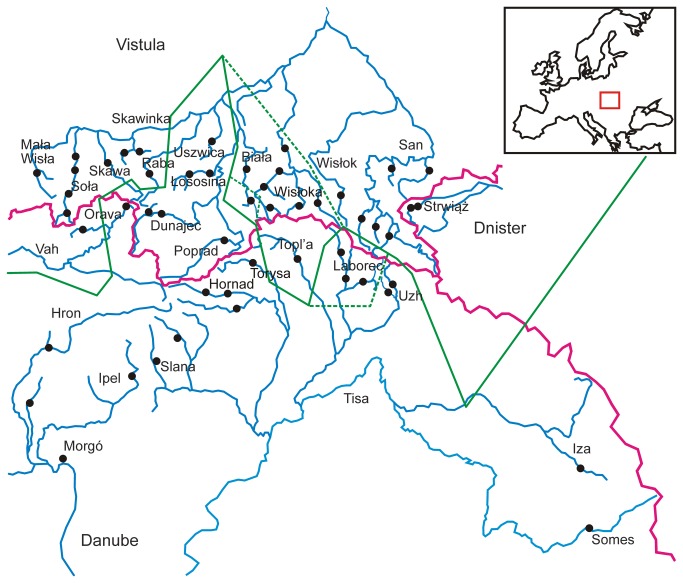
Spatial distribution of clusters detected in an assignment test performed in TESS.Solid green line – border between clusters when K = 2, dashed line – borders of the 3rd cluster for K=3.